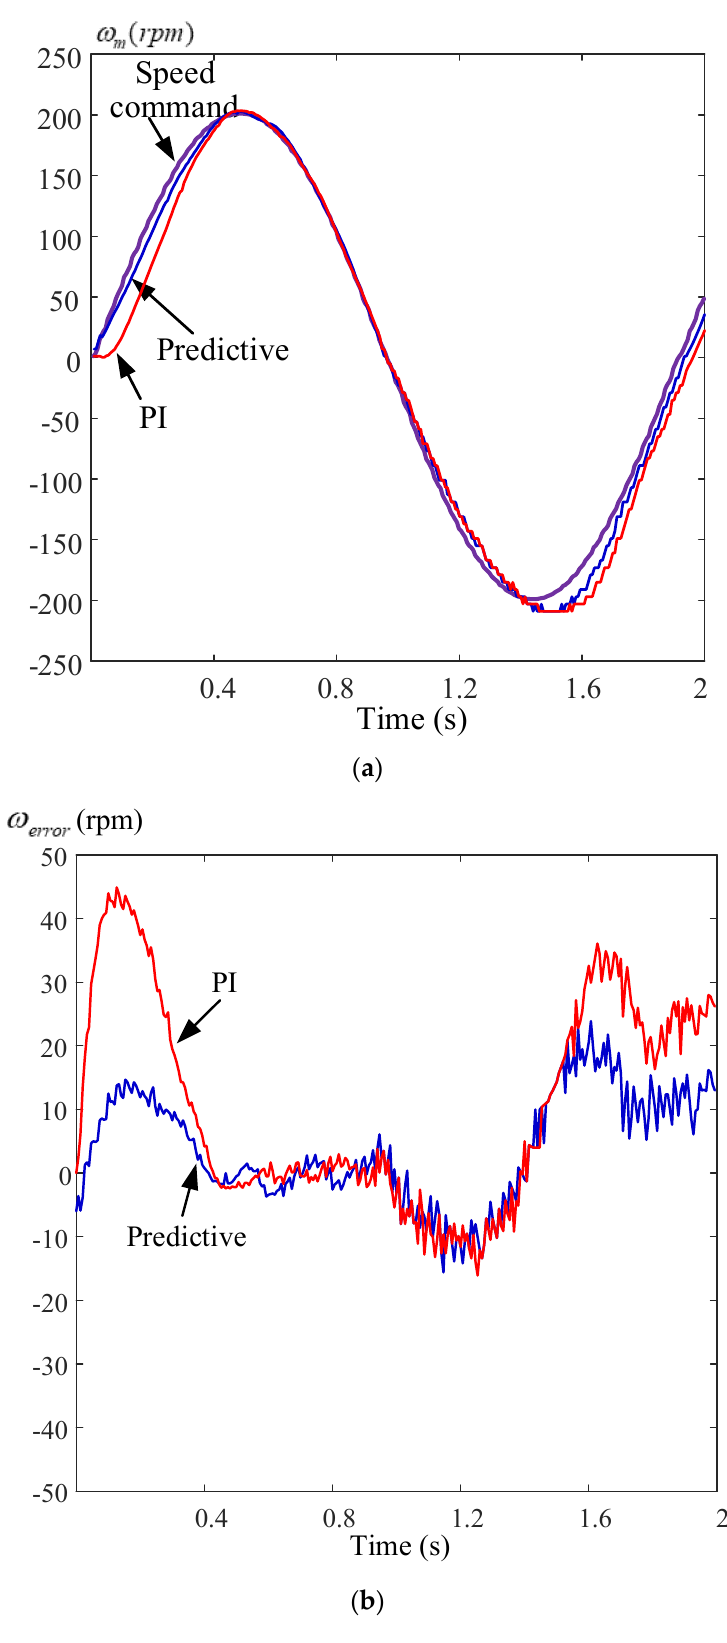
Figure 12. Measured sinusoidal responses using different controllers at 200 r/min. ( a ) speeds, ( b ) errors.